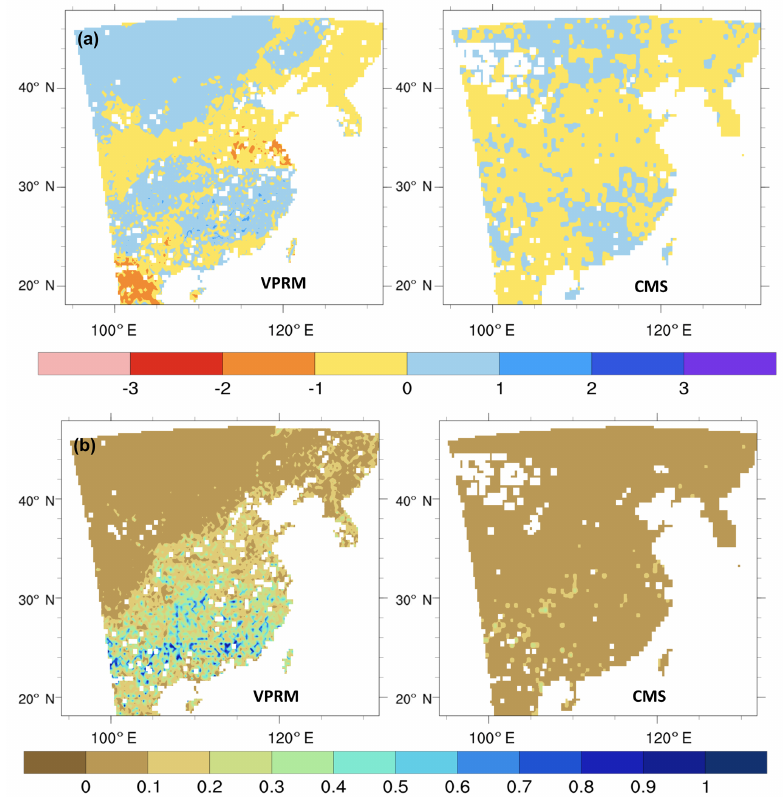
Figure 7. Annual NEE (kgCm − 2 ) modeled by VPRM-CHINA and CMS reported as multiyear (2005–2009) (a) means and (b) 1 σ standard